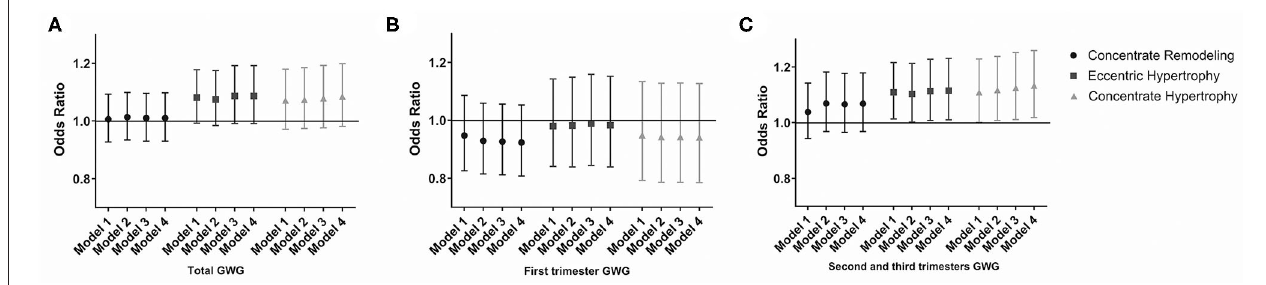
FIGURE 1 | Odds risk (OR) of LVH in offspring with maternal GWG during different gestational trimesters. (A) OR of LVH in offspring with maternal GWG in total trimester. (B) OR of LVH in offspring with maternal GWG in first trimester. (C) OR of LVH in offspring with maternal GWG in second and third trimesters. Data are presented as OR (95%CI). Model 1: adjusted for maternal factors, including age, race, educational level, drinking, passive smoking, pre-pregnancy BMI, GDM and gestational hypertension. Model 2: adjusted additionally for gestational age, sex of offspring, delivery mode, parity. Model 3: adjusted additionally for BMI at 4 years of age. Model 4: adjusted additionally for BP at 4 years of age. BMI, body mass index; GWG, gestational weight gain; LVH, left ventricle